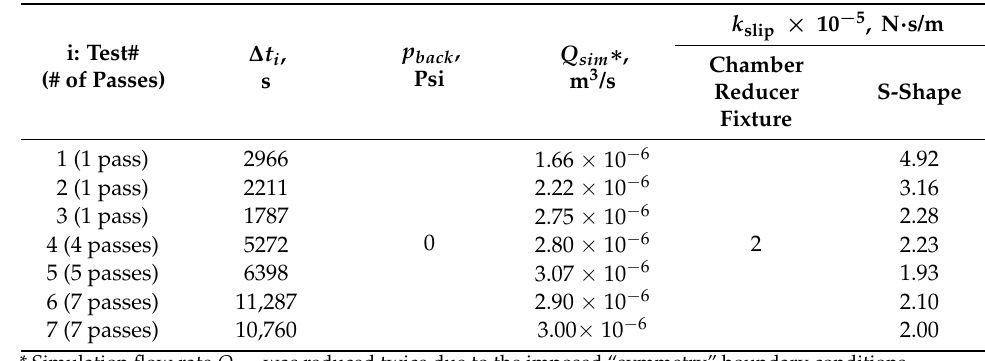
Table A2. S-Shape: CFD setup parameters (full AFM system).